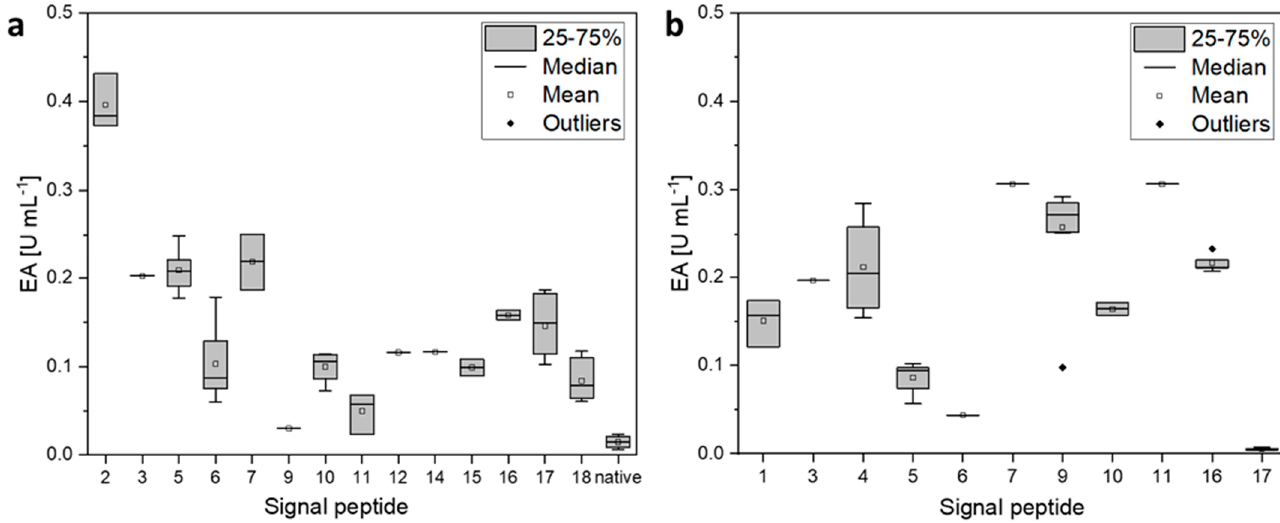
Figure 7. Box plot representation of enzyme activities of BmasPGA in the supernatant obtained by secretion with specific SPs of pMSP3 ( a ) and pMSP4 ( b ). In ( a ), the activity of BmasPGA secreted with the native SPs of all screenings is also plotted.